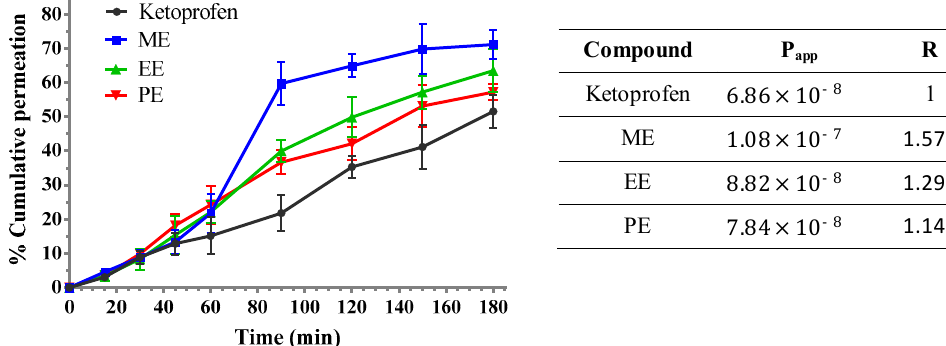
Figure 2. % Cumulative intestinal permeation of ester prodrugs of ketoprofen assayed by ex vivo Ussing chamber method; data was expressed as mean ± SEM, where n = 3. ME: Methyl 2-(3-benzoyl phenyl) propanoate, EE: Ethyl 2-(3-benzoyl phenyl) propanoate, PE: Propyl 2-(3-benzoyl phenyl) propanoate, Papp: Apparent permeability, R: Absorption enhancement ratio. A value of * p < 0.05 (compared to ketoprofen) was considered significant.